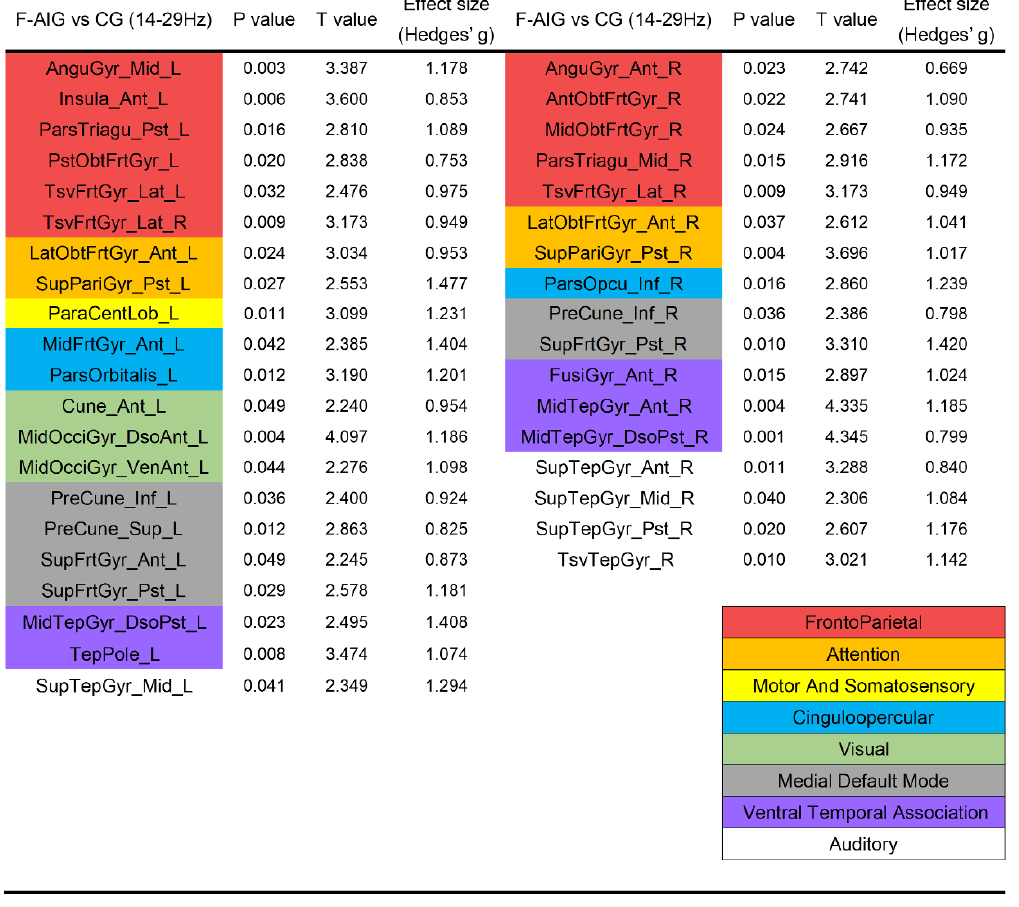
Figure 5. Comparison of ROIs’ activation between F -AIG and CG in beta band. F-AIG: female action observation-induced group; CG: control group; L: left, R: right; p < 0.05, FDR corrected (for the full name of ROIs see Supplementary Table S1). Colors for functional modules: red: frontoparietal sys- tem; orange: attention system; yellow: motor and somatosensory system; blue: cinguloopercular system; green: visual system; grey: medial default mode system; purple: ventral temporal associa- tion system; white: auditory system.